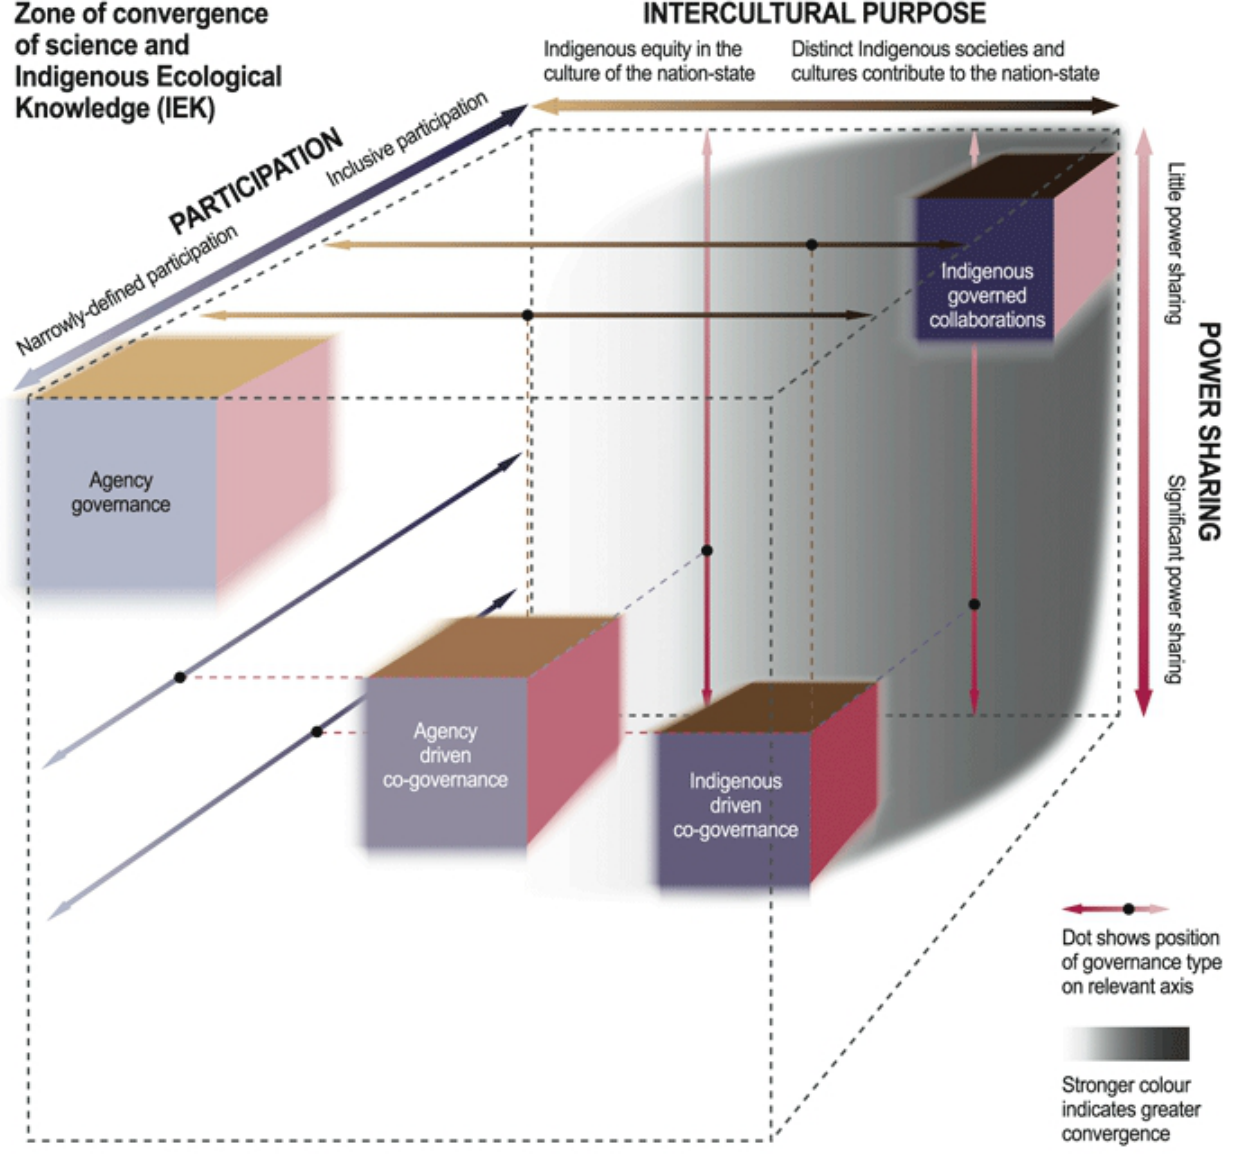
Fig. 2 . Position of types on the three axes, namely participation, intercultural purpose, and power sharing, and the zone of convergence of western science and Indigenous Ecological Knowledge (IEK) that emerges in the Indigenous-governed and Indigenous-driven co-governed